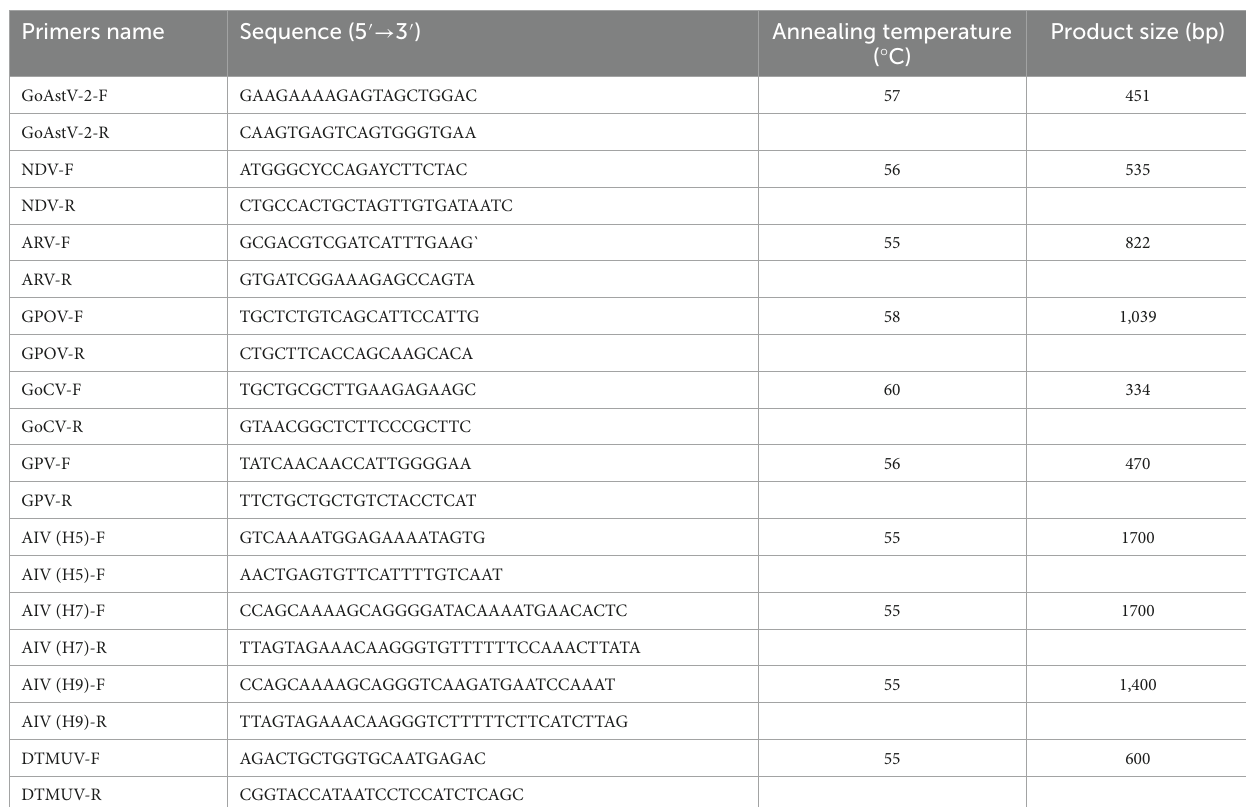
TABLE 1 PCR identification primers for other